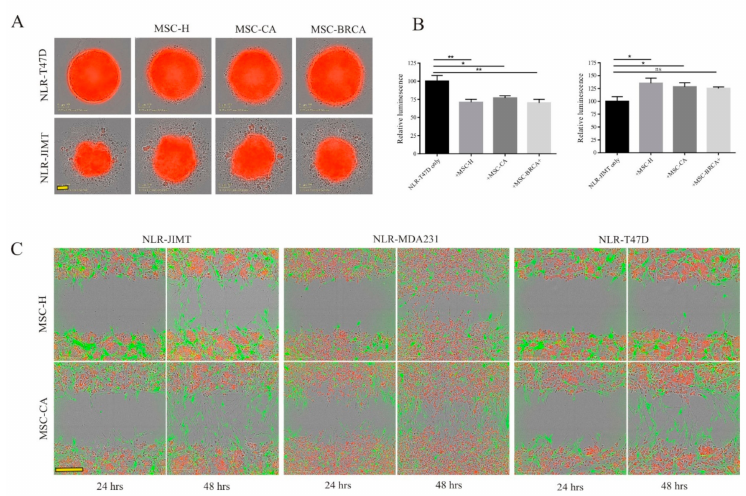
Figure 7. Faster invading cancer patient-derived MSCs are followed by more rapidly invading tumor cells. ( A ) Monoculture vs. co-culture in 3D non-adherent culture conditions showed less compact NLR-T47D-MSC spheroids and bigger NLR-JIMT-MSC spheroids, but no di ff erence between MSC isolates was observed. Scale bar: 100 µ m. Breast cancer cells—red color, MSCs—unstained. ( B ) Luminometric measurement of spheroid cultures after 7 days revealed significantly lower ATP amount in NLR-T47D-MSC co-culture and higher ATP amount in NLR-JIMT-MSC co-culture (* p < 0.05; ** p < 0.01; Mann–Whitney test). In the control group (only breast cancer cells without MSC), 8 samples were analyzed. In each group with MSC, 4 spheroids were analyzed. ( C ) MSC-CA exhibited increased invasion potential in Scratch wound invasion assay after 24 or 48 h. The invasion of tumor cells was also increased in co-culture with MSC-CA compared to MSC-H (1 × 10 4 MSCs + 2 × 10 4 NLR-MDA231 / NLR-T47D and 1.5 × 10 4 MSCs + 3 × 10 4 NLR-JIMT were seeded on Matrigel coated 96-well plates and covered with 50% Matrigel). Scale bar: 200 µ m. MSCs used for analysis did not exceed 10th passage. MSCs were stained with Vybrant ™ CFDA SE Cell Tracer Kit (green color), breast cancer cell lines expressed red fluorescent